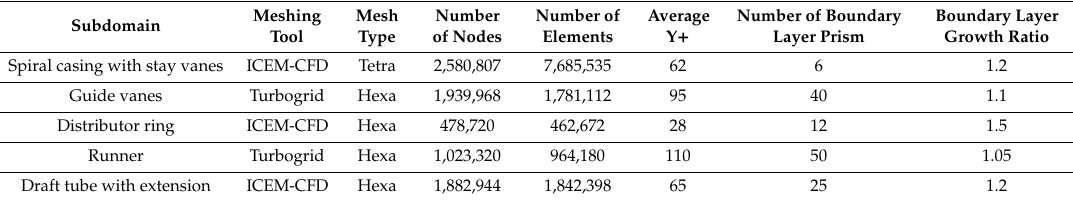
Figure 2. Turbine computational domains: ( a ) close up of the runner domain in meridional view; ( b ) 3D view of the overall domain; ( c ) close up of the computational mesh in the region close to the runner/draft tube interface; ( d ) top view of the overall domain; ( e , f ) details of the draft tube mesh. Table 1. Details of the grids used in the